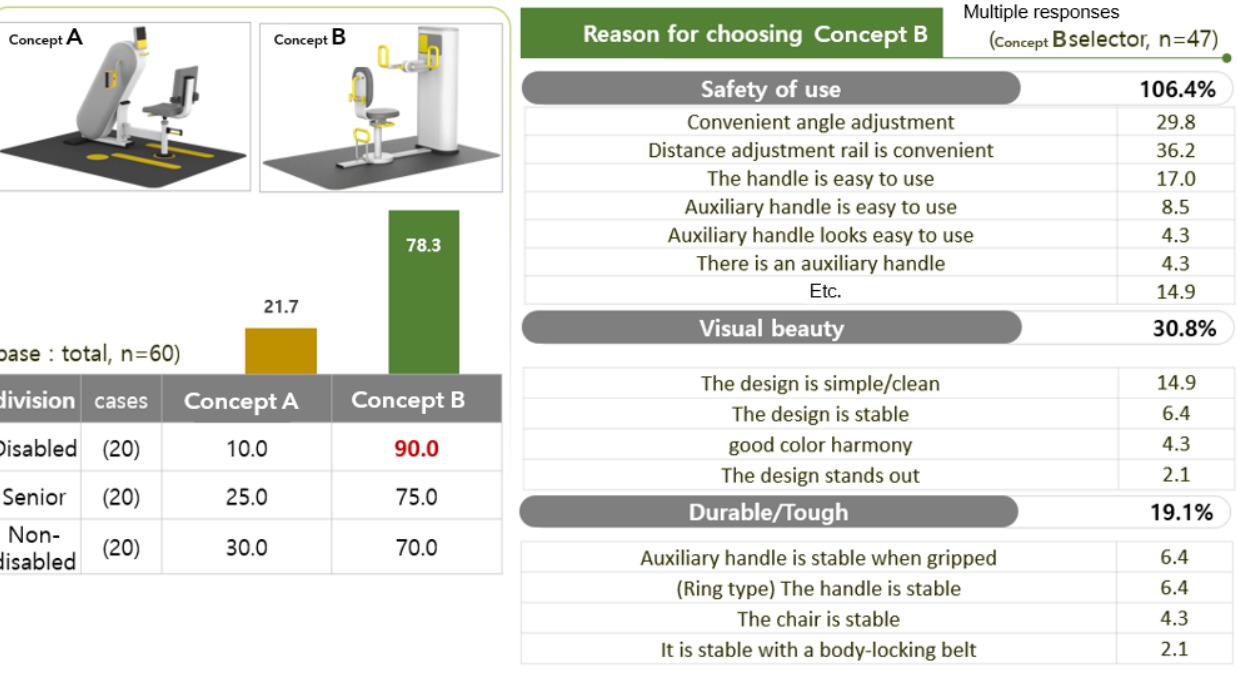
Figure 14. Results of the preference property evaluation of the arm ergometer product design .